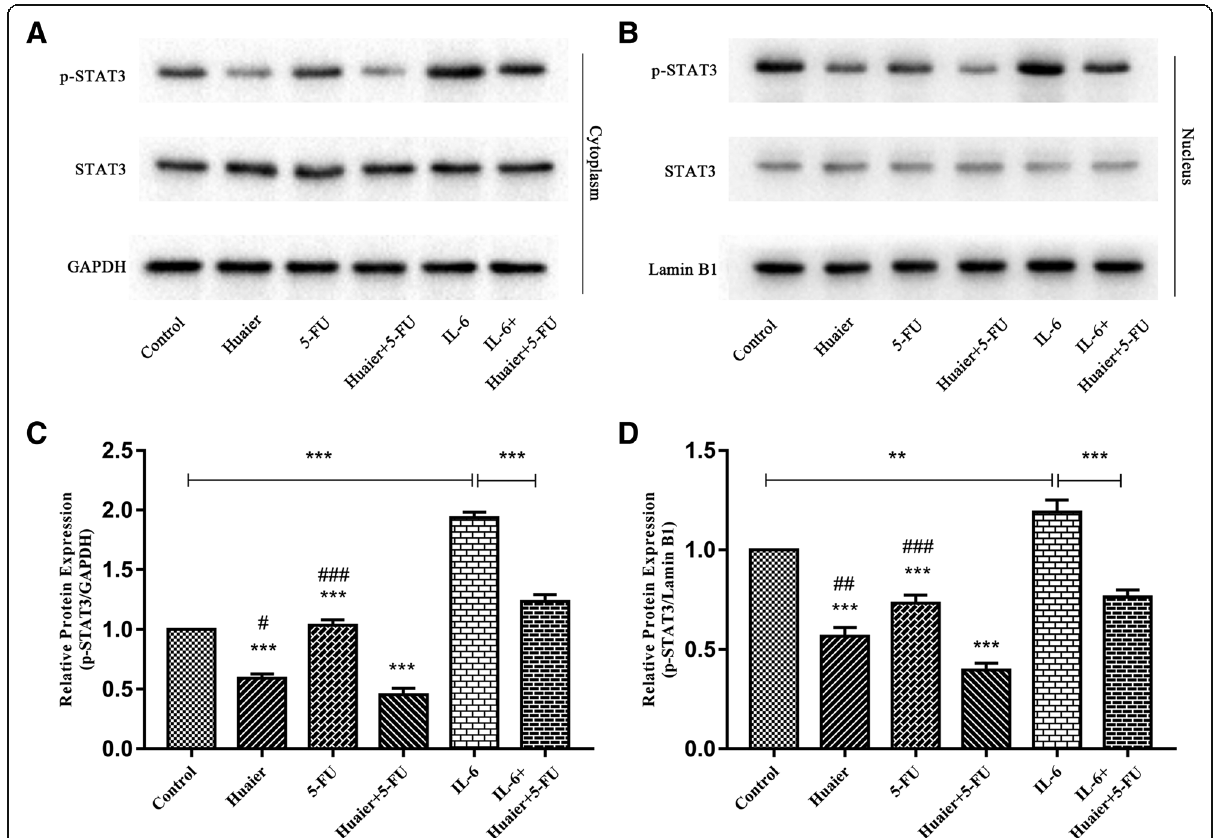
Fig. 5 Huaier synergized with 5-FU promoting the inhibition of both constitutive and Inducible STAT3 phosphorylation by IL-6. The total STAT3 and p-STAT proteins expression in cytoplasm ( a and b ) and nucleus ( c and d ) were detected using Western blot after 48 h treatment with Huaier and 5-FU alone or in combination. In the meantime, the effect of combination therapy on p-STAT3 Induced by IL-6 were also checked. Relative optical density of proteins were analyzed by Image J. All results are expressed as mean ± SD of three independent experiments. * P < 0.05, ** P < 0.01, *** P < 0.001, compared with control group, while # P < 0.05, ## P < 0.01, ### P < 0.001, compared with combination